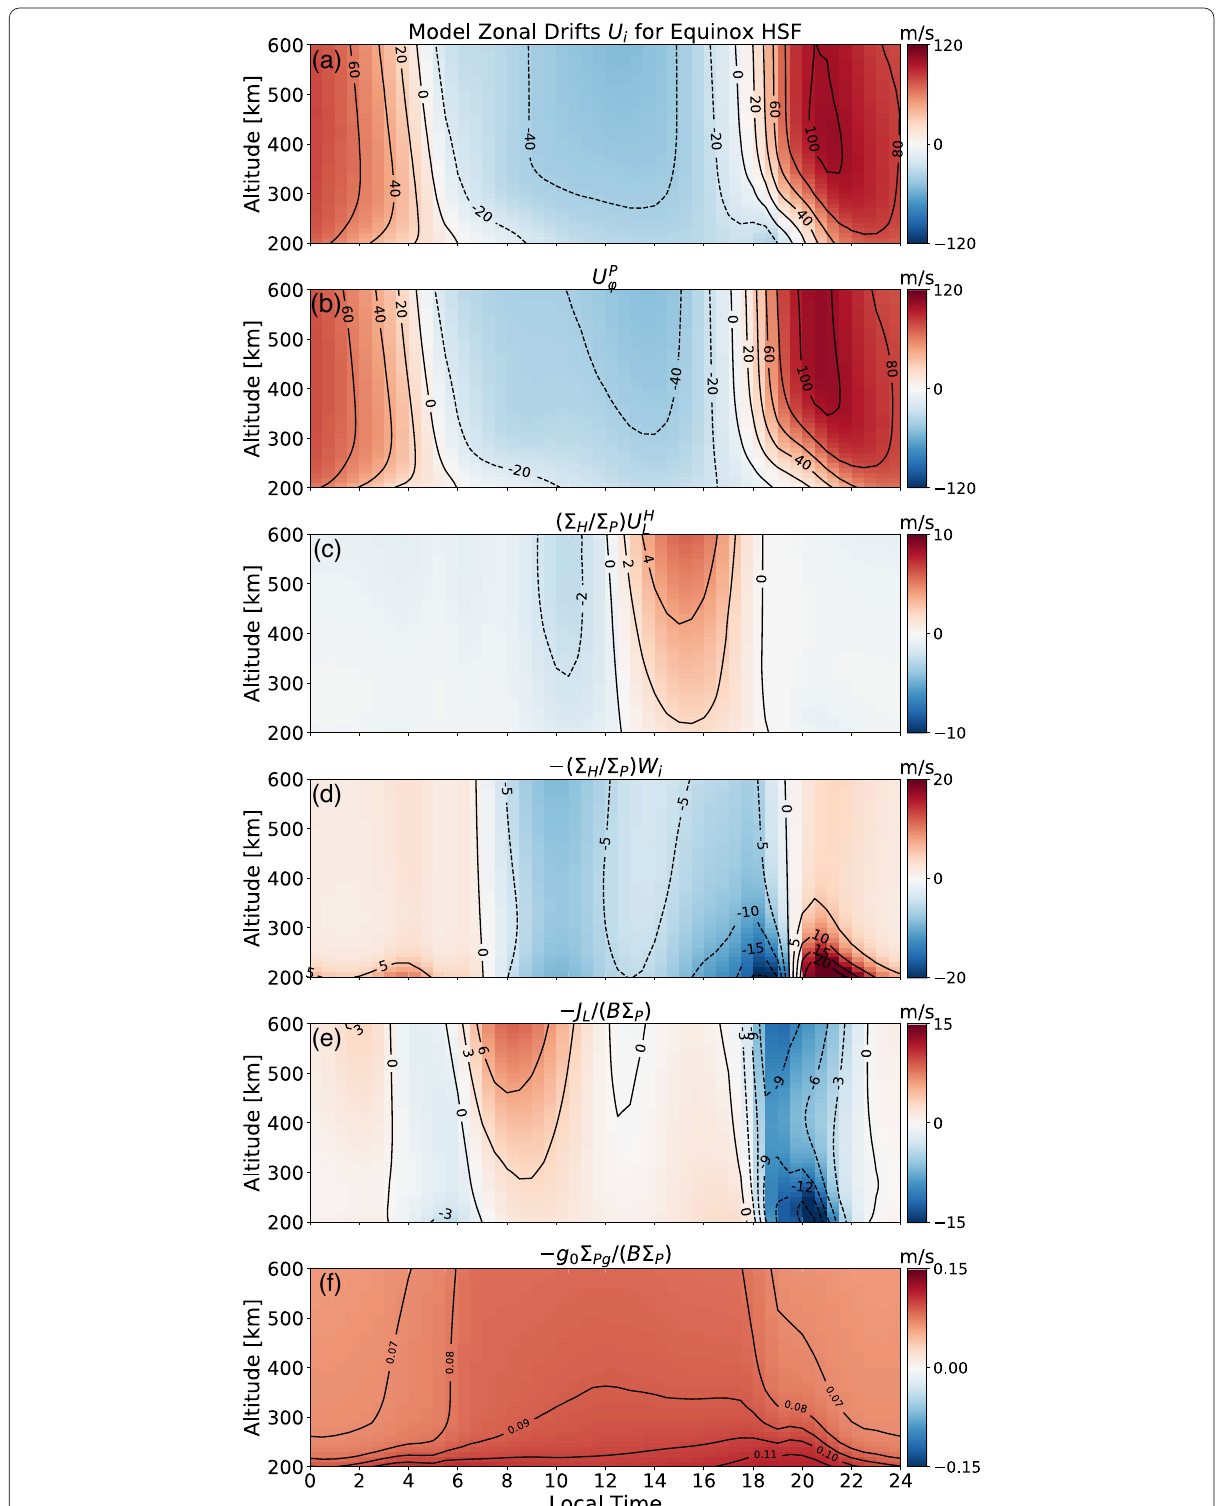
Fig. 6 a Zonal drifts modeled by DINAMO for equinox HSF conditions and b – f contributions from different terms of Eq. 17 to these drifts. All values are given in